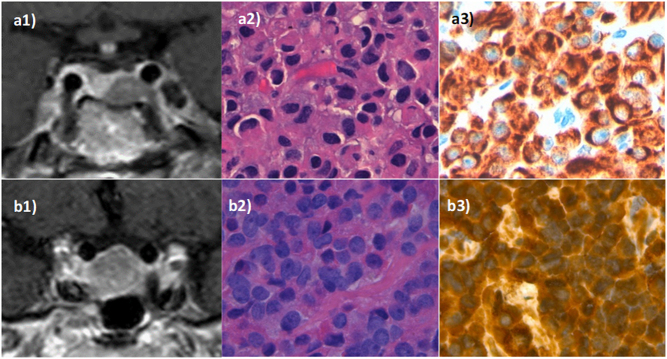
Radiological and histological images of soft and hard tumors. Image a1 represents a soft Knosp grade 0 GH macroadenoma in a patient pre-treated with somatostatin receptor ligands (SRL) for 84 months, surgical remission was achieved (coronal T2 sequence). This pituitary adenoma presented high cellularity separated by fine connective tracts (a2), and strong and diffuse positivity for GH (a3) in histological exams. Image b1 (T1 coronal with gadolinium administration) shows a very hard Knosp grade 2 GH macroadenoma tumor in a patient not pre-treated with SRL. He was cured after surgery. This tumor presented high cellularity separated by fibrous septa (b2) and diffuse and strong positivity for GH (b3) in histological exams.